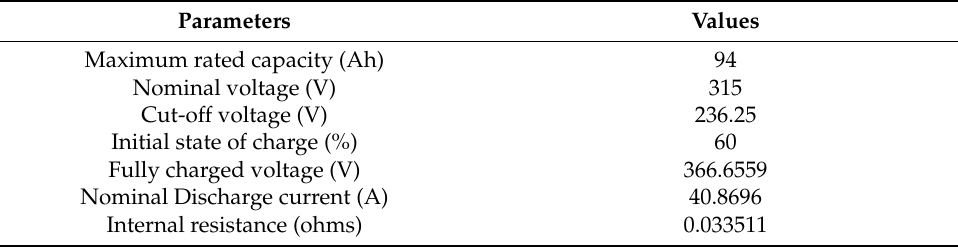
Table 10. Battery Table 10. Battery specifications.